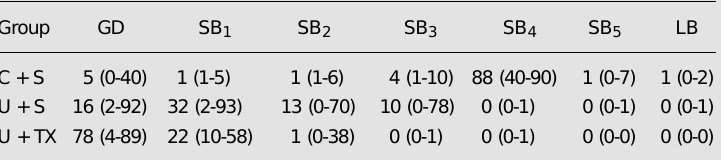
Table 1 - Percentages of the total radioactivity along the gastrointestinal tract 1 h after instillation into the proximal duodenum of 1.0 ml saline labeled (S) with 99 technetium coupled to an unabsorbable carrier in control awake (C + S, N = 16) animals and in groups of urethane (U)-anesthetized rats treated with scorpion toxin (U + TX, N = 8) or saline (U + S, N =